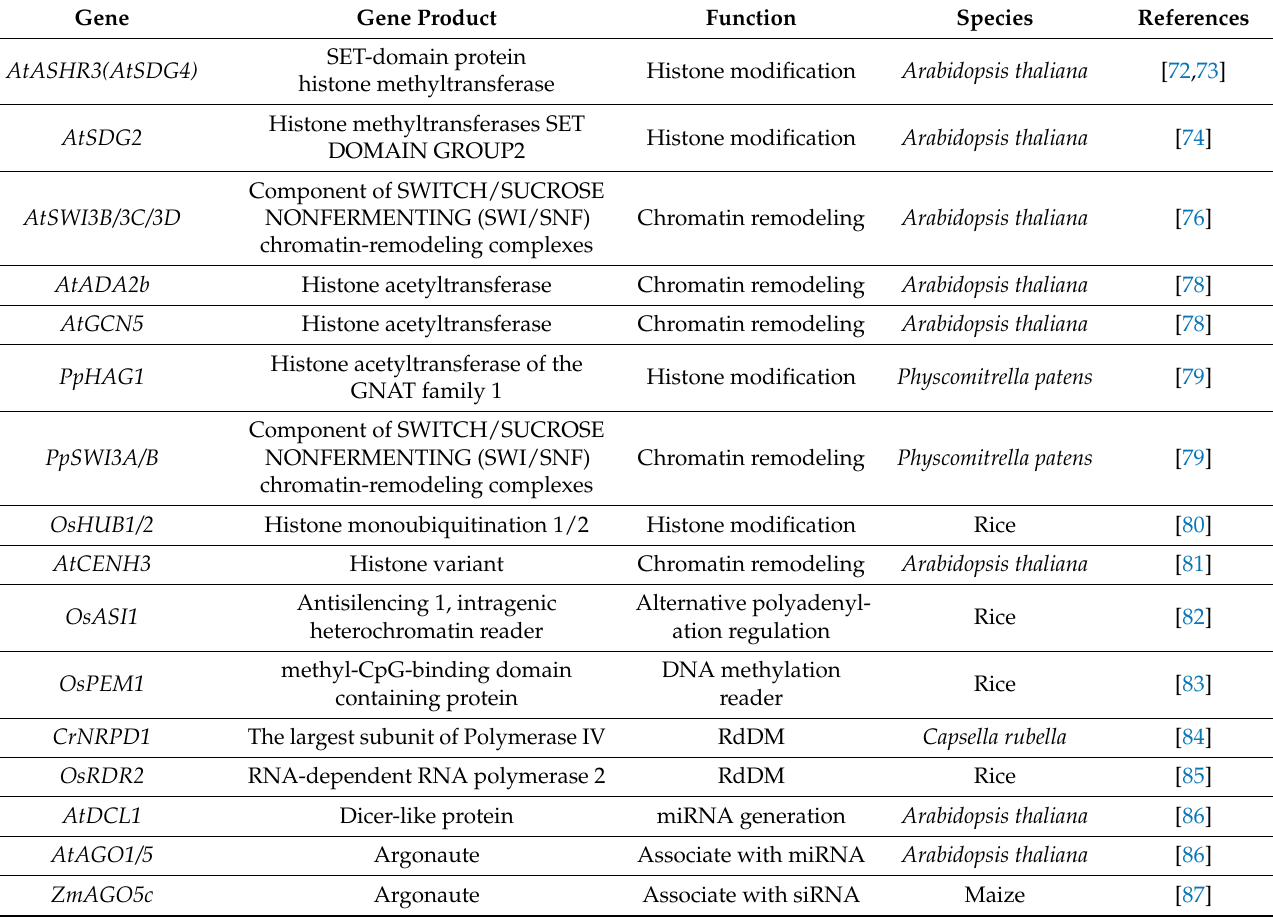
Table 1. Identified epigenetic regulation-related genes that are involved in pollen